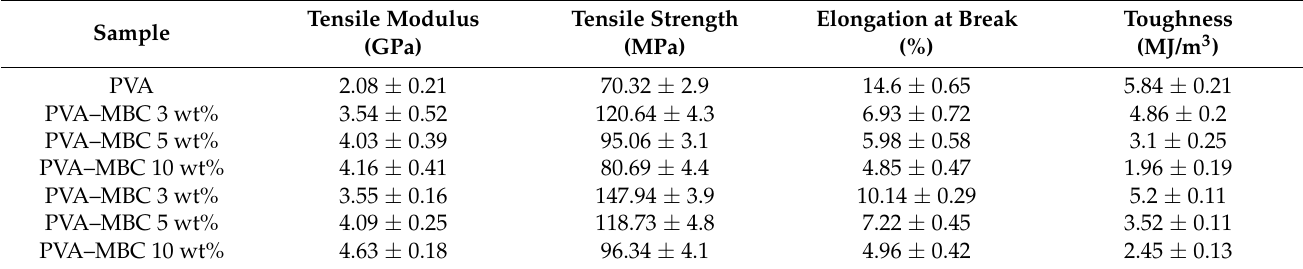
Table 6. Mechanical properties of PVA and PVA–BC composites [96].